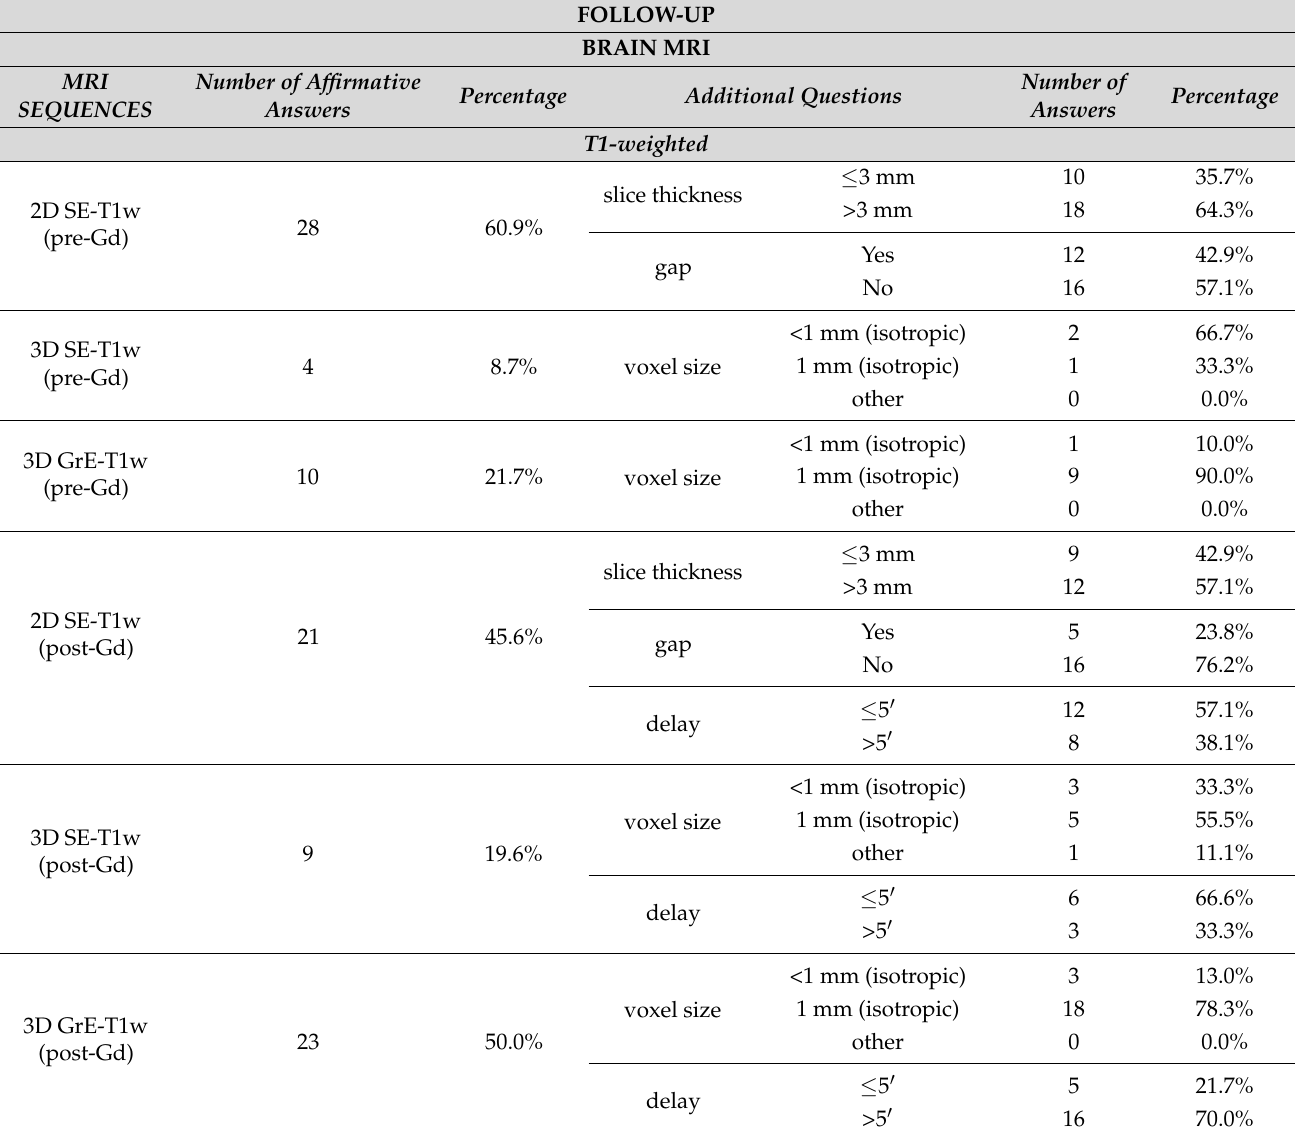
Table 2. Results of the survey regarding brain and spine MRI at follow-up.